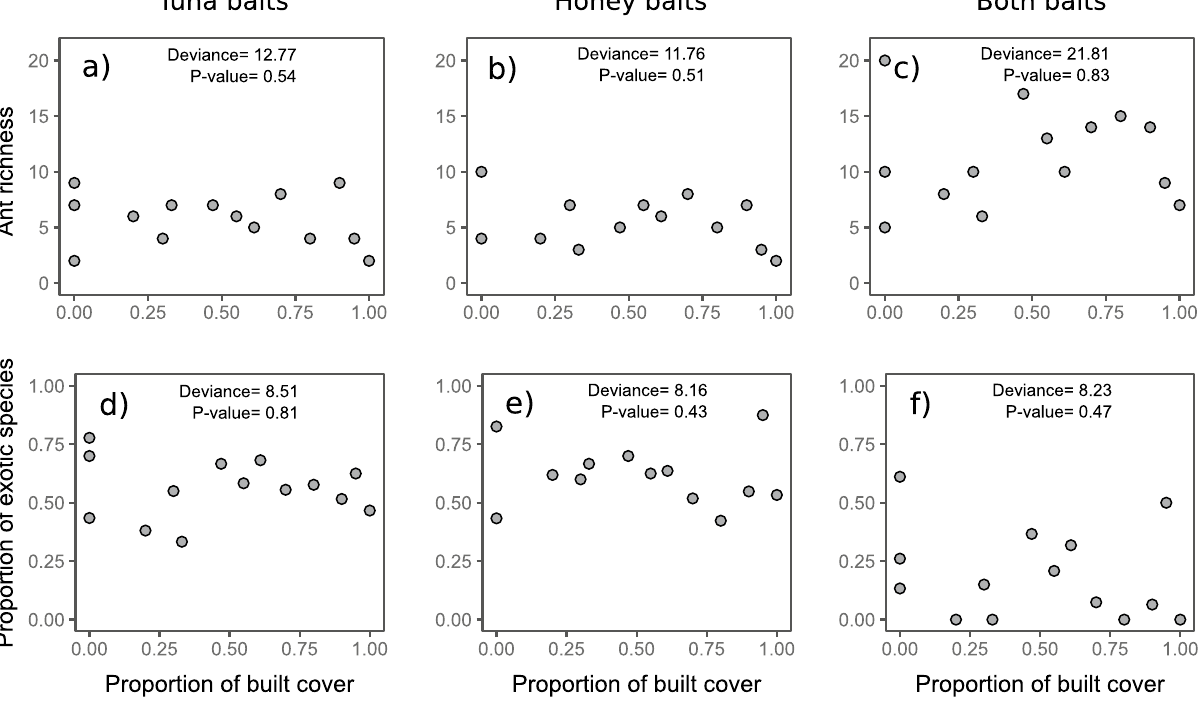
Figure 2. Scatterplots of the relationship between the built cover gradient and ant richness and the proportion of exotic species sampled in tuna, honey, and both baits considered